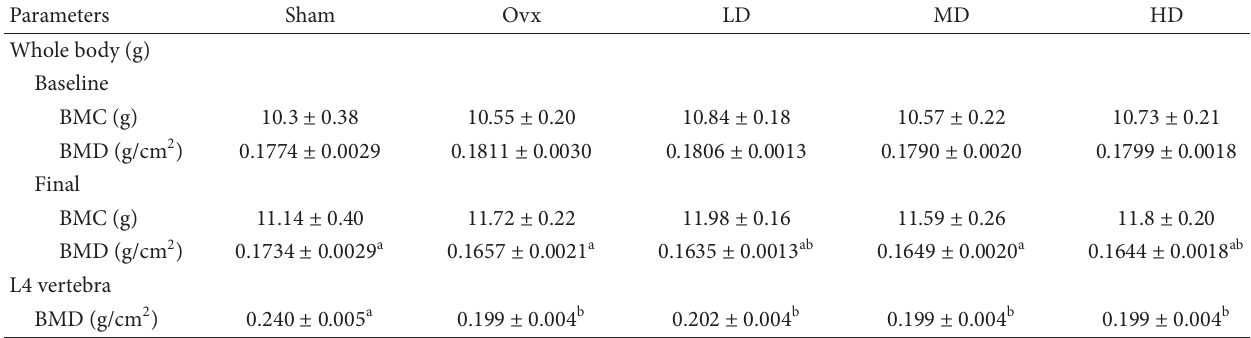
Table 2: Effects of ovariectomy (Ovx) and three doses of vitamin E: low dose (LD, 300mg/kg diet), medium dose (MD, 525 mg/kg diet), and high dose (HD, 750 mg/kg diet) on DXA bone parameters of whole body and fourth lumbar vertebrae